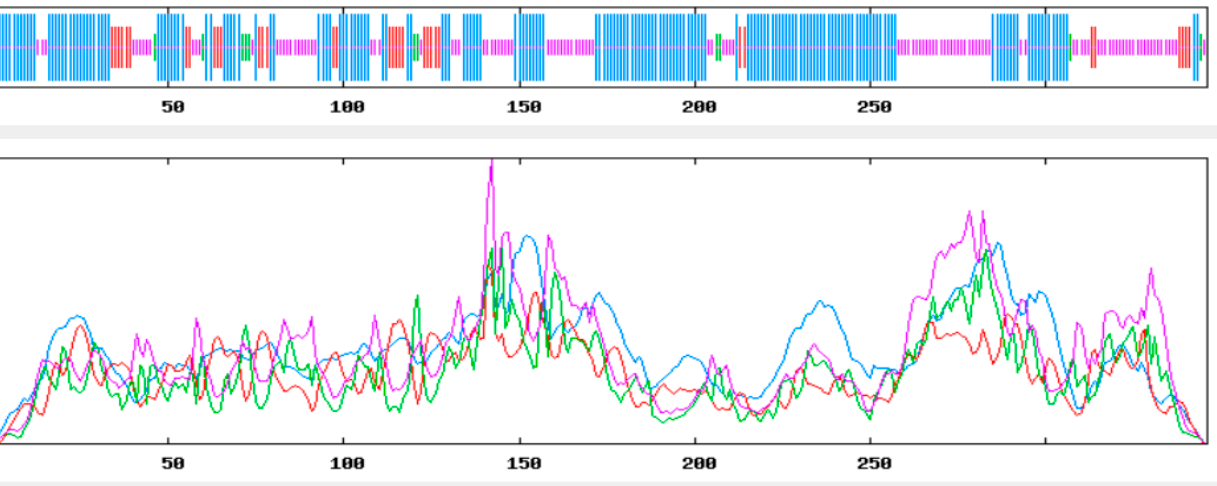
Figure 4. SOPMA result (dark blue is denoting alpha helix, green is denoting pi helix, dark pink is denoting beta bridge, red is denoting extended strands).